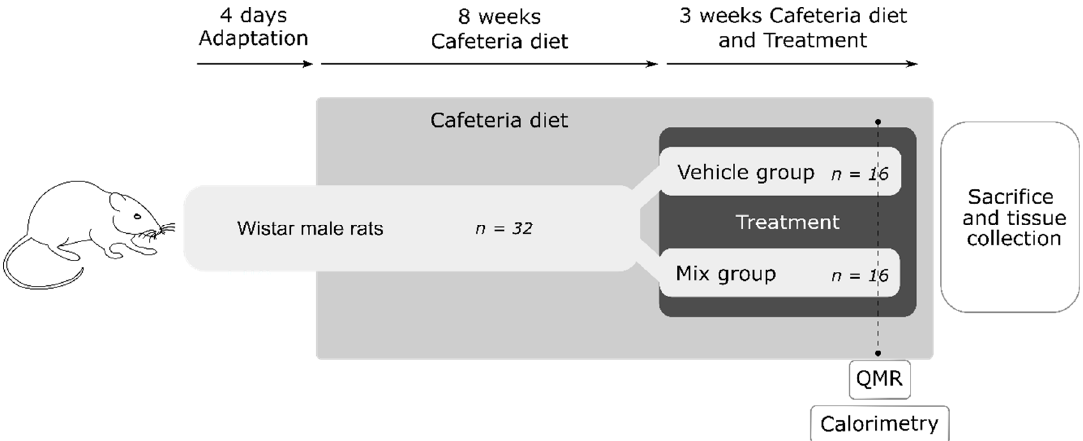
Figure 1. Experimental design of the animal study. A total of 32 Wistar male rats were adapted to the housing conditions for four days. Animals were fed a cafeteria diet ad libitum for 11 weeks. The body weight and food intake of the animals were recorded once each week. After eight weeks of cafeteria diet, animals were randomly distributed in two groups ( n = 16) and orally supplemented with a mix (mix group) of natural ingredients, composed of 25 mg grape seed proanthocyanidin extract (GSPE)/kg body weight, 100 mg conjugated linoleic acid (CLA)/kg body weight, 100 mg anthocyanins/kg body weight, and 55 mg of chicken feet hydrolysate (CFH)/kg body weight, diluted in a sugary solution (sucrose/water; 1:1 w/v ) or with the vehicle (VH group), composed of 400 mg/kg of maltodextrin diluted in the same sugary solution. After three weeks of treatment, animals were sacrificed and tissues collected. Four or five days before sacrifice, indirect calorimetry was performed on eight random animals per group for 24 h. One day prior to sacrifice, the fat mass and lean mass of the other eight animals per group were analyzed by quantitative magnetic resonance (QMR).